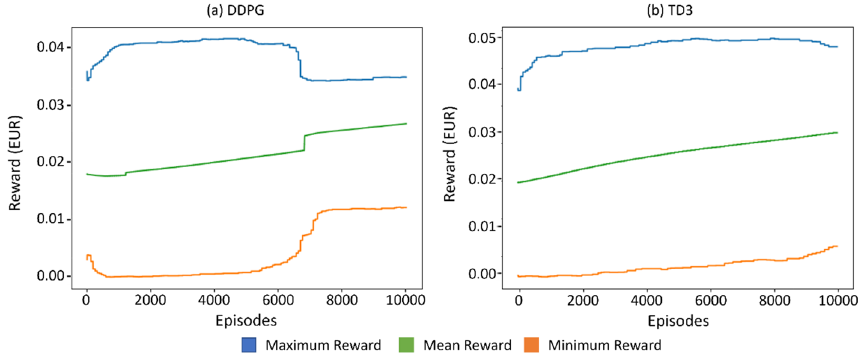
Fig. 8 Maximum, mean, and minimum reward per training episode: ( a ) DDPG, and ( b ) TD3